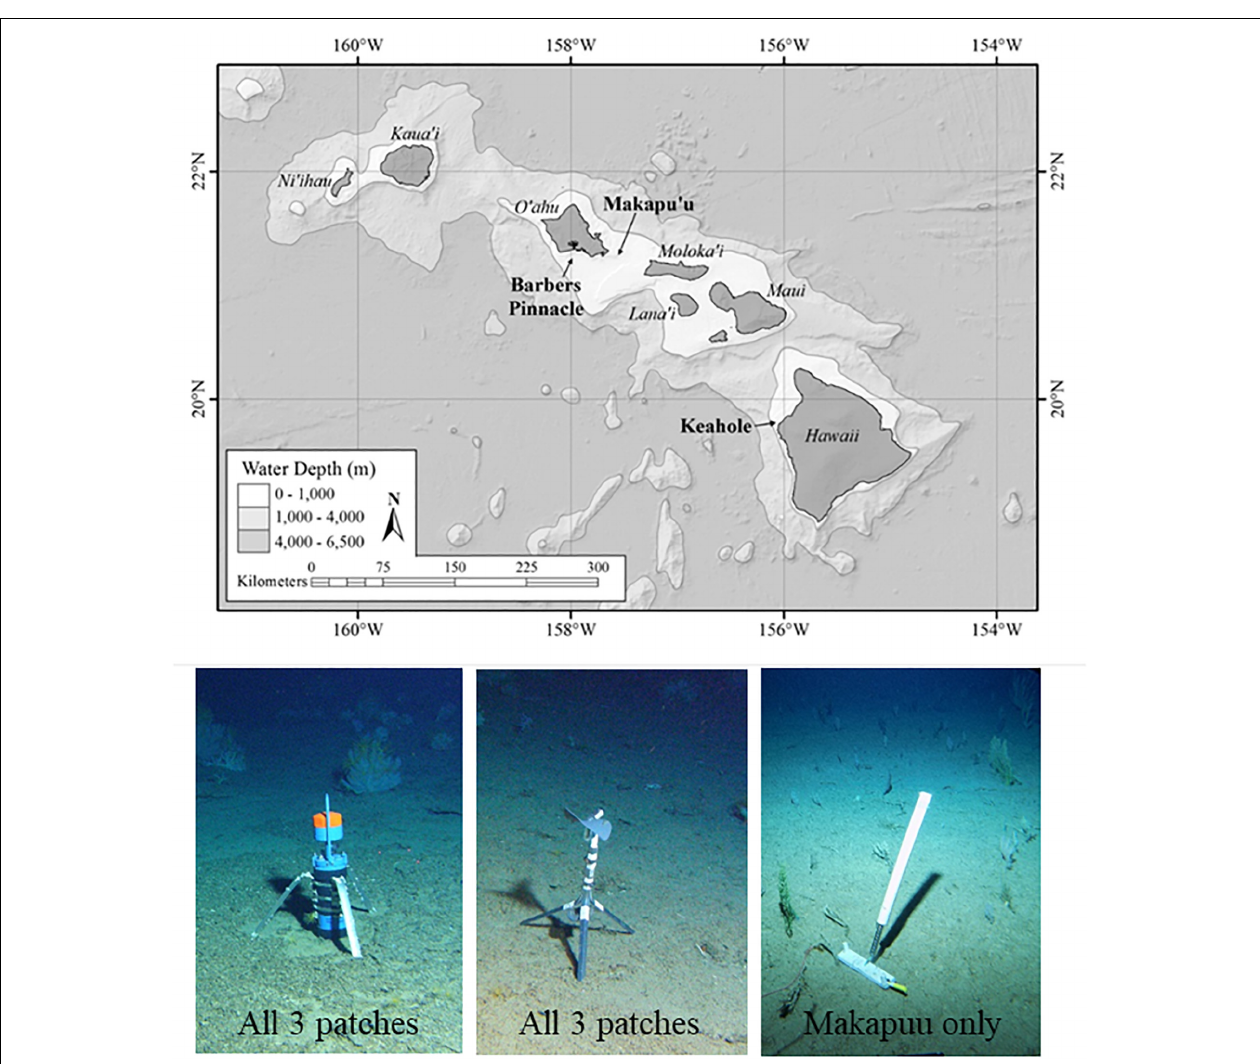
FIGURE 1 | Map of the main Hawaiian Islands showing the locations of the three coral patches whose environment was monitored with instruments, two on the south, and south-east platform base of O‘ahu and one on the edge of the west Hawai‘i shelf. Photos indicate the types of instruments used: acoustic current meter (left), flowmeter (center), tiltmeter